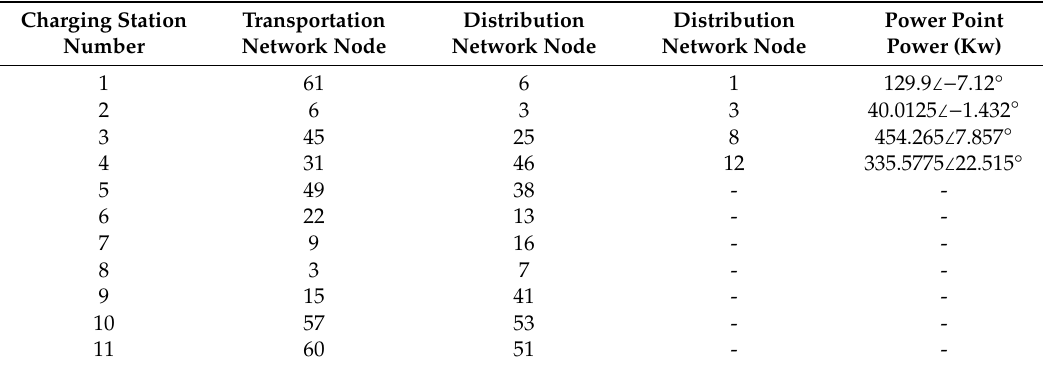
Table A1. Charging station number, 57-node distribution network node and transportation network node coupling correspondence table.